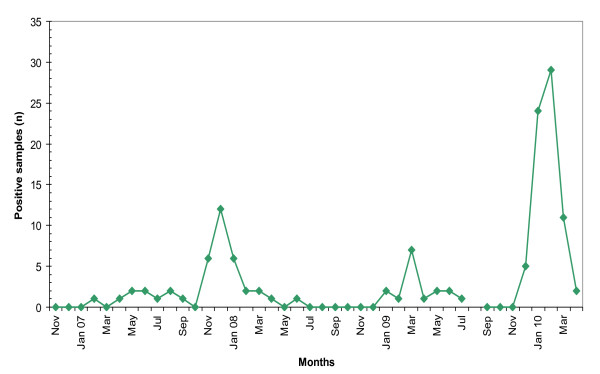
Monthly human metapneumovirus detection by DFA in nasopharyngeal aspirates from hospitalized children between November 2006 and April 2010.